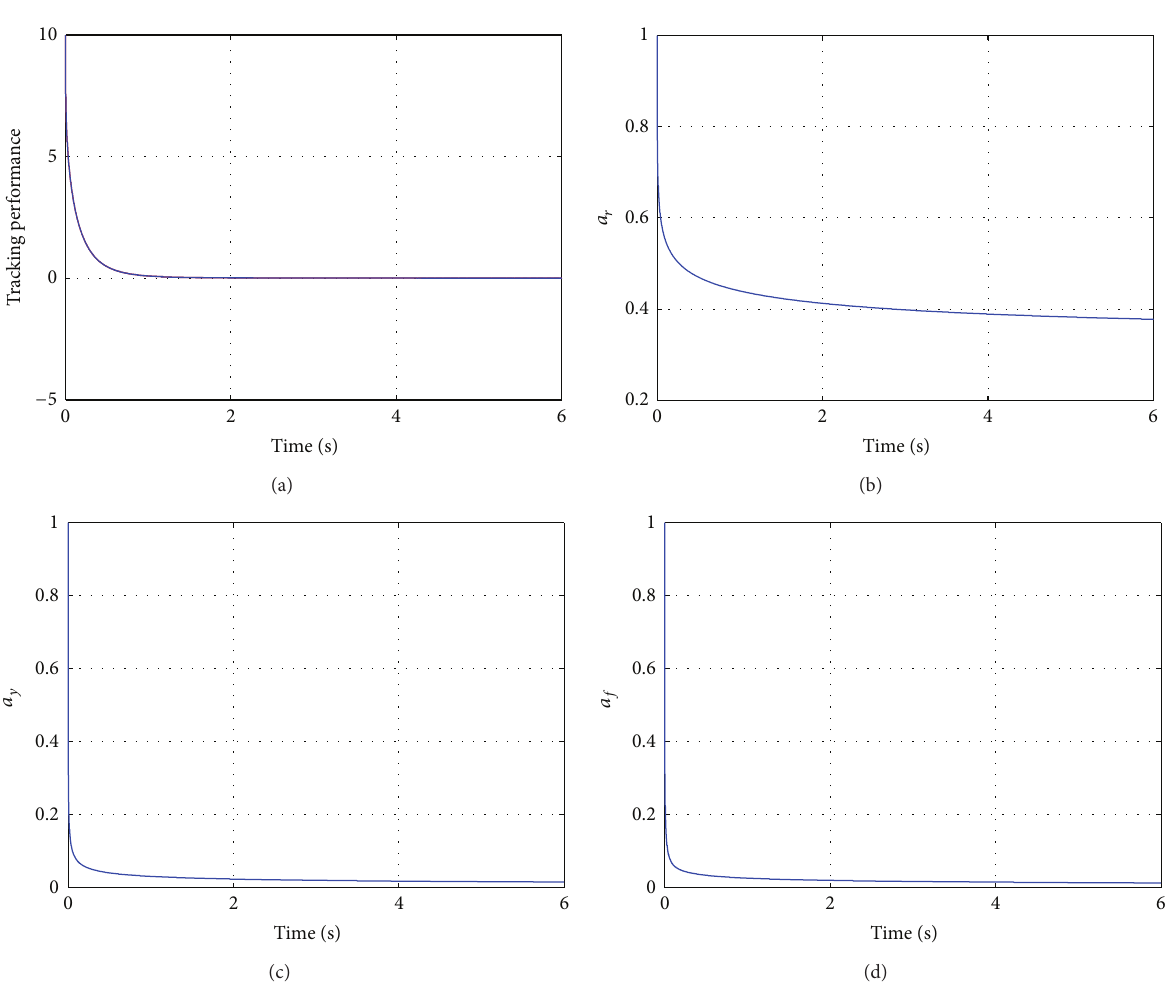
Figure 2: Fractional adaptive control of the fractional nonlinear system (26). (a) Tracking performance (red line represents the state of the fractional nonlinear plant, while, blue line represents the state of the fractional reference model); (b) control parameter ̂𝑎 𝑟 (𝑡) ; (c) control parameter ̂𝑎 𝑦 (𝑡) ; (d) control parameter ̂𝑎 𝑓 (𝑡)